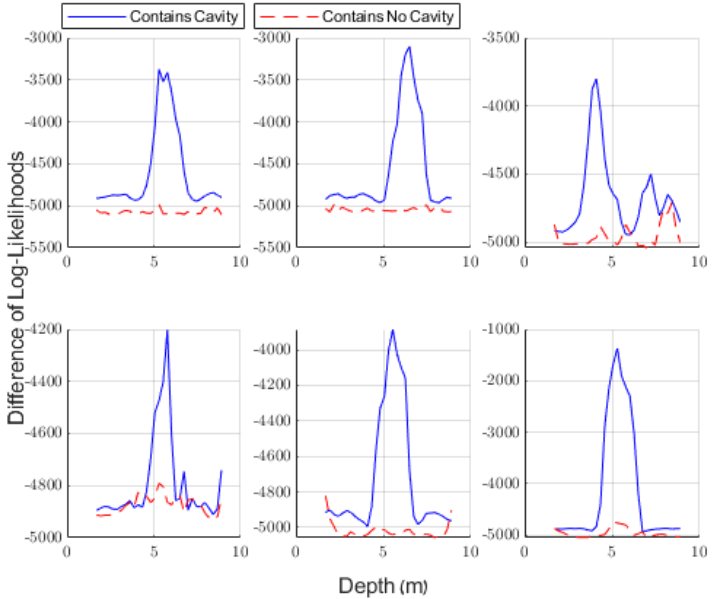
Figure 11. The results of applying our method to simulated stratified soils. In each case, the cavity is located approximately at the depth of the peak of the solid blue likelihood-ratio curve. We examined the frequency range of 10–55 MHz, used a window size of two depths (0.48 m), and used a guard distance of 8 depths (1.92 m). The cavities were assumed to have a width of 1.5